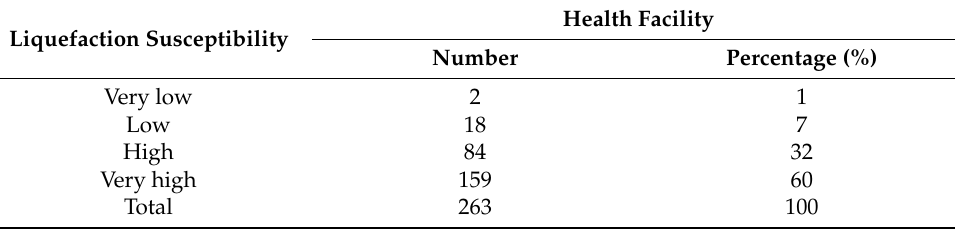
Table 5. Health facilities in the valley falling on a different zone of liquefaction susceptibility. Liquefaction